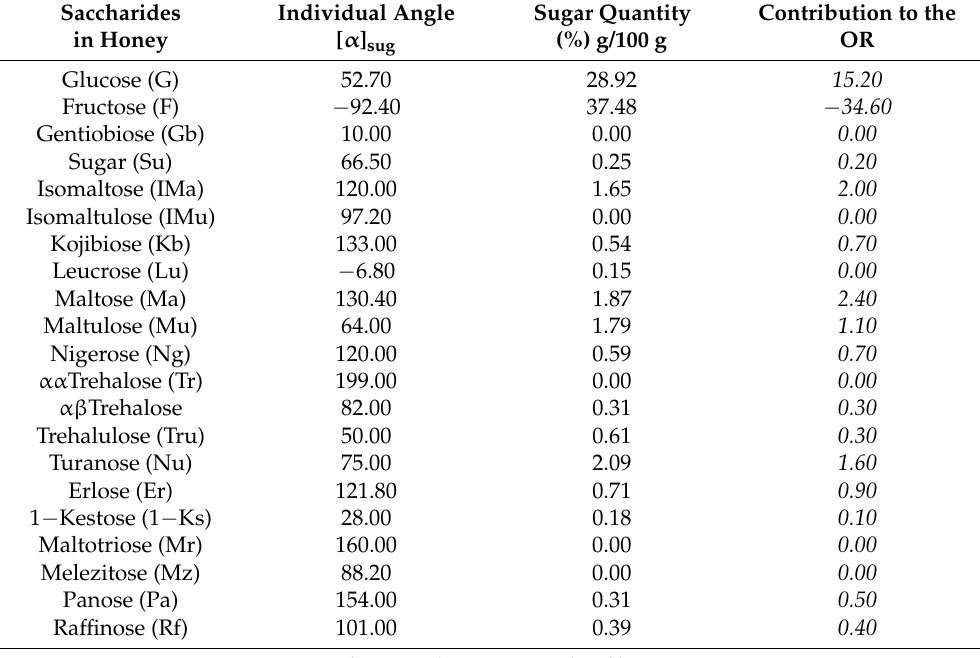
Table 2. Example for calculation of specific optical rotation of honey using the sugar